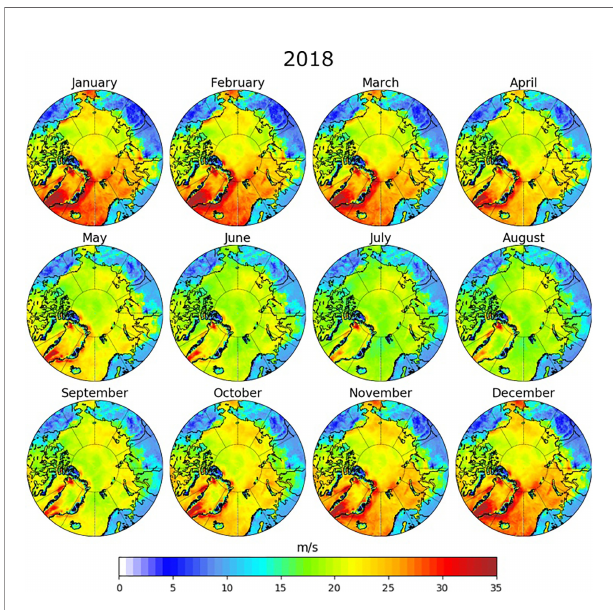
FIGURE 9 | U 100 10 (ms -1 ) for 2018 obtained with a POT analysis and a GPD distribution for the TS-EVA seasonal approach. Data obtained from the ERA5 dataset.